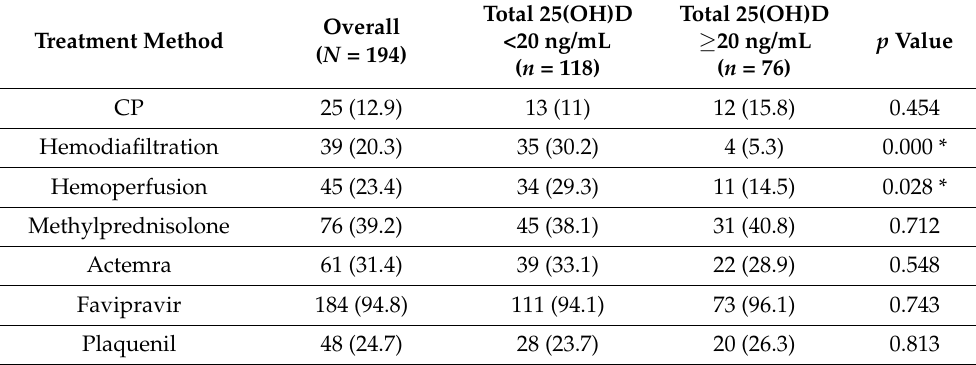
Table 4. Comparison of treatments for COVID-19 patients according to the vitamin D status.